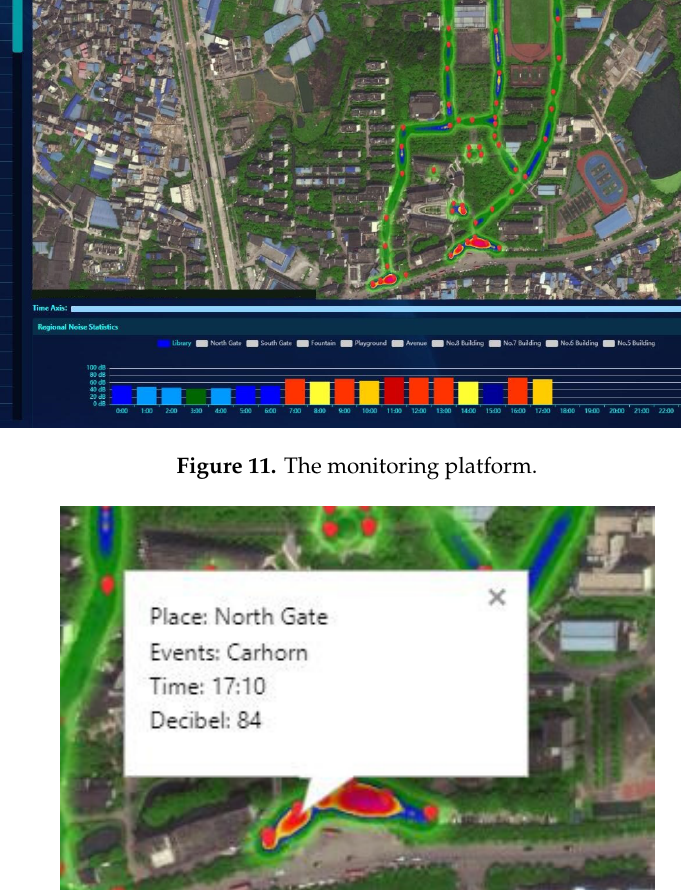
Figure 12. The presentation of acoustic event information.